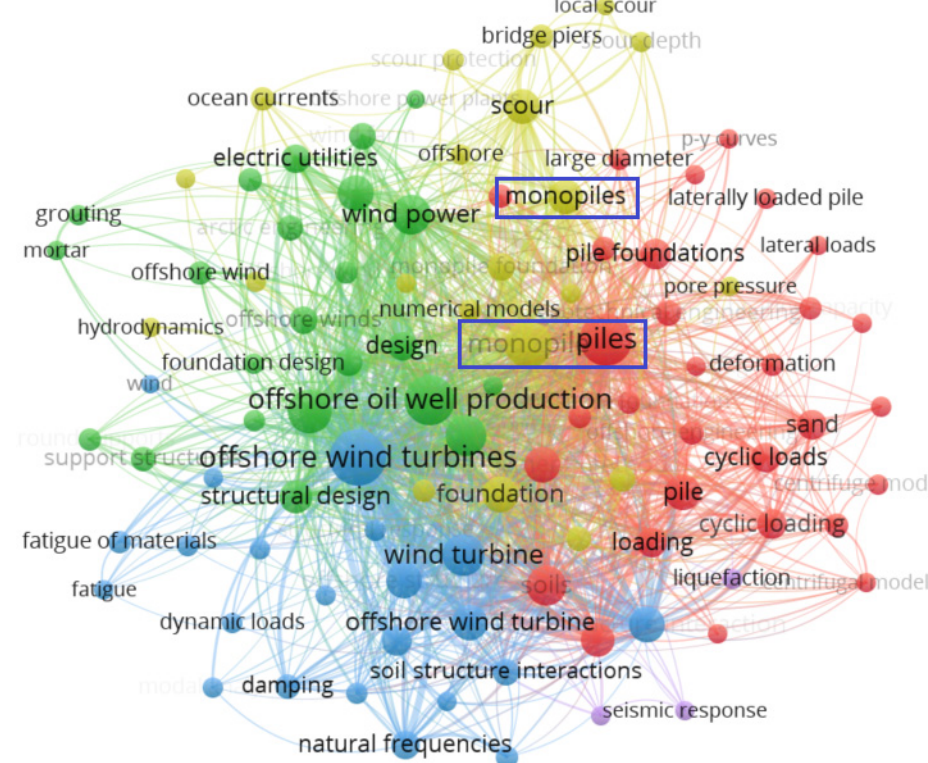
Figure 9. Bibliometric map of published research for monopile